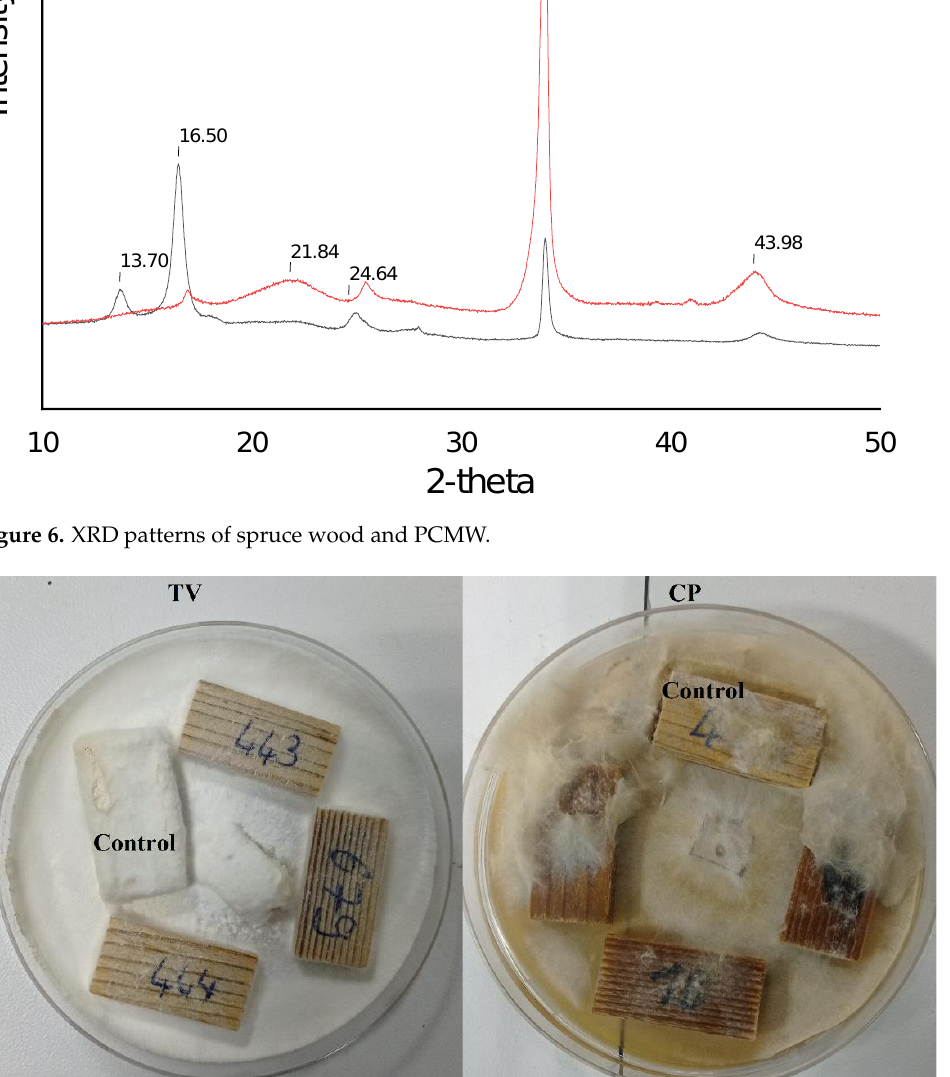
Figure 7. Samples after decay test: white rot fungus ( A ) and brown rot fungus ( B ).